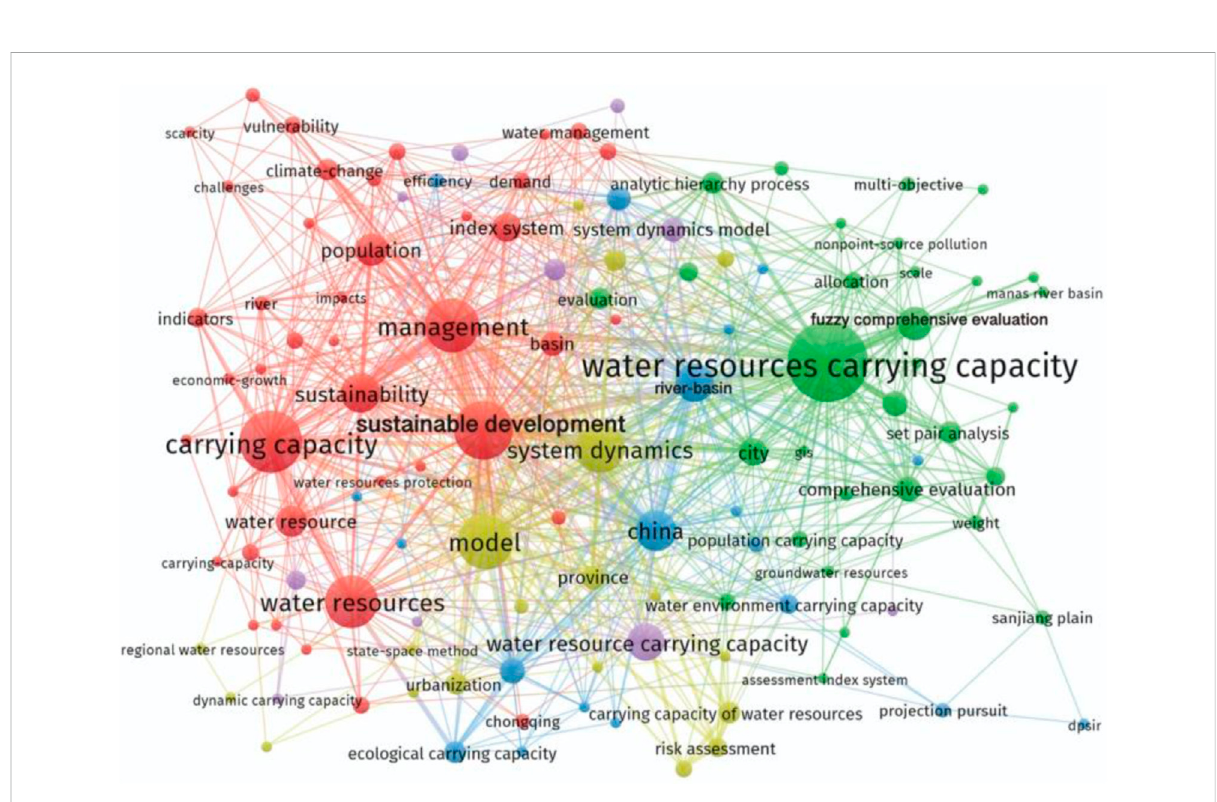
FIGURE 5 Keywords